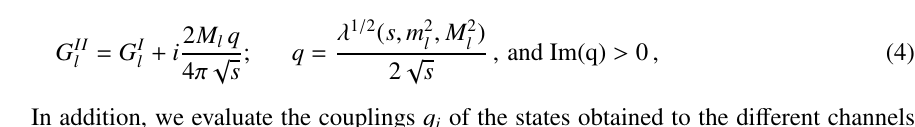
Table 1. The coupling constants to various channels for the poles in the J P = 1 / 2 − sector, with 3054 . 05 + i0 .